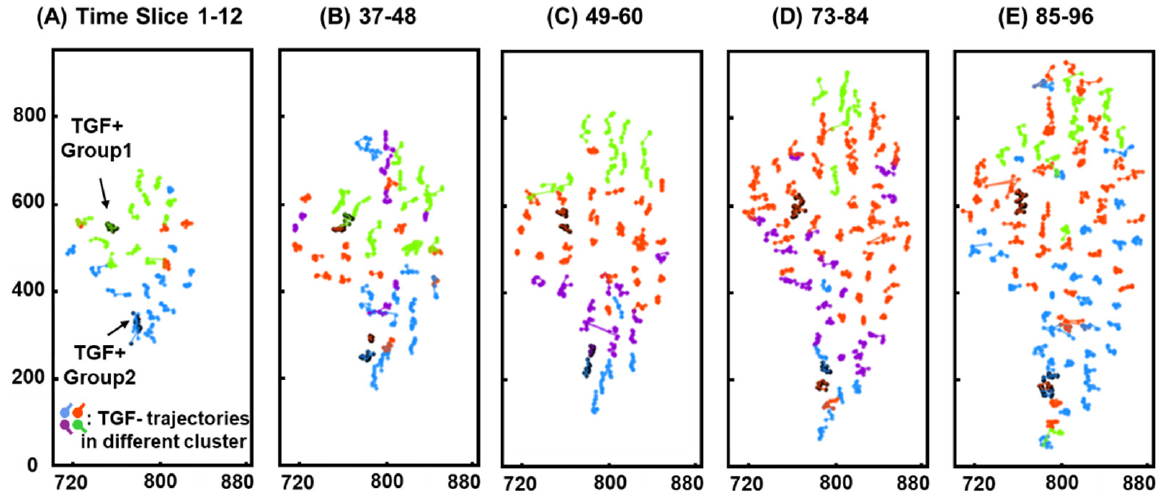
Figure 4. Cell trajectories’ positions combined with clustering results. ( A − E ) Two groups of TGF (+) cells are marked black pointed by arrows. Colors represent different clusters.